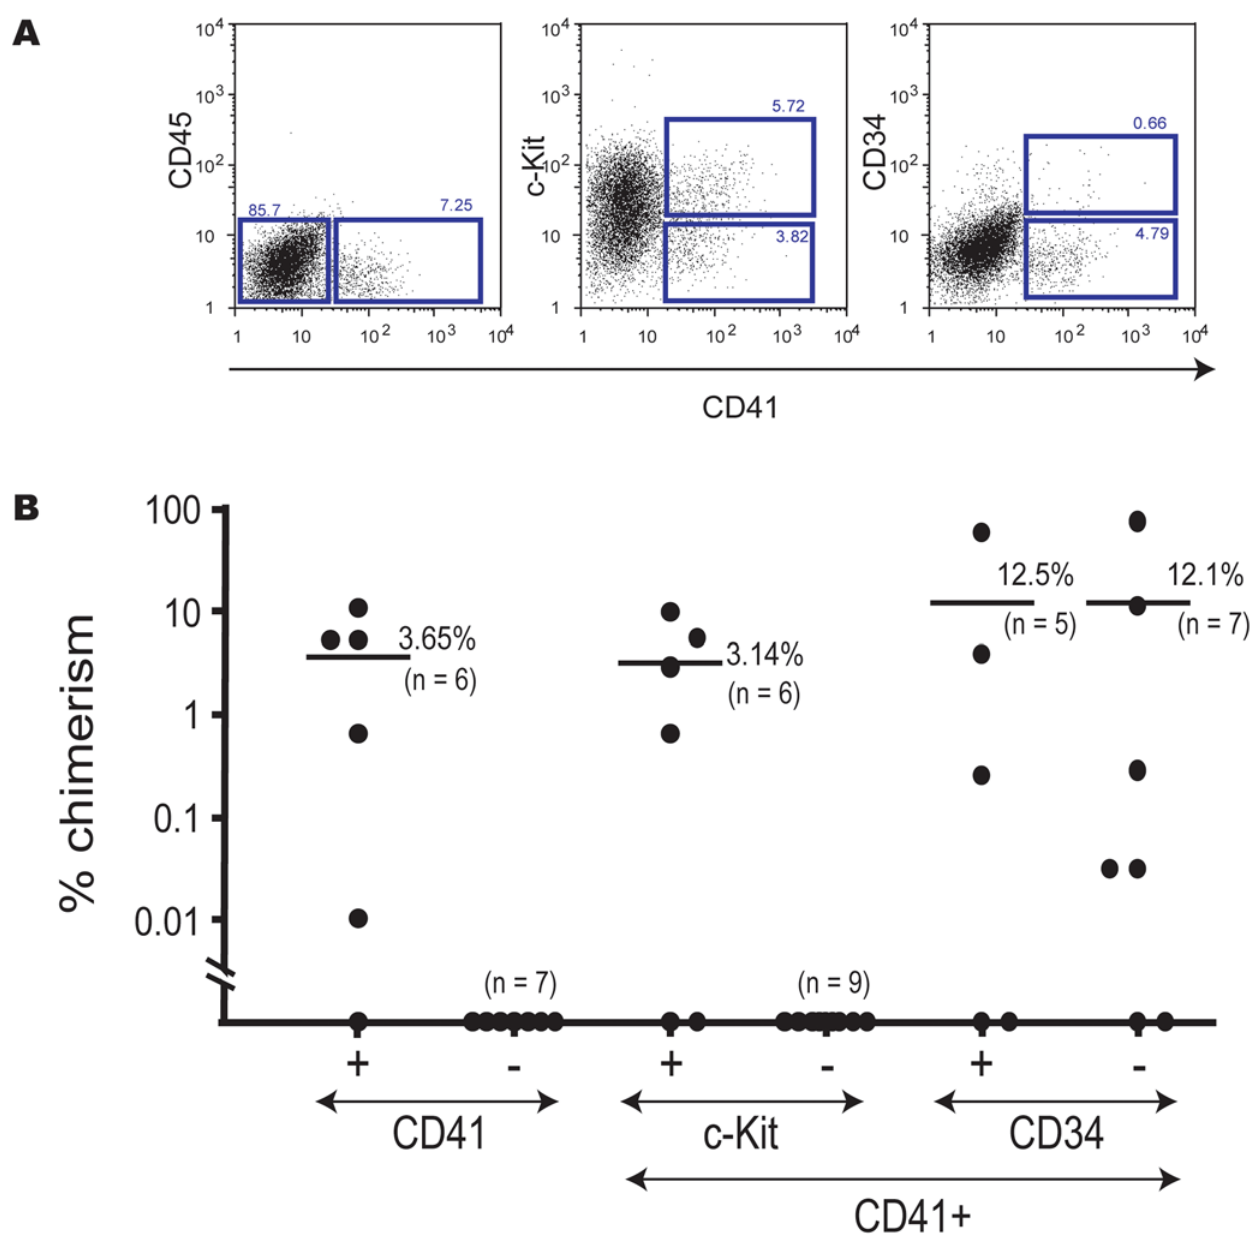
Figure 2. EB6 subpopulations with the potential of giving rise to HSCs. (A) Data from flow cytometry analysis show the expression of CD41, CD45, c-Kit, and CD34 in EB6 cells. The sorting gates for CD41 2 or CD41 + cells, c-Kit + CD41 + or c-Kit 2 CD41 + cells, and CD34 + CD41 + or CD34 2 CD41 + cells are indicated as squares. (B) EB6 cells were fractionated based on expression of CD41, c-Kit, and CD34, co-cultured with OP9 cells for 4 days, sorted for GFP + cells, and transplanted into lethally irradiated mice. HOXB4 expression was maintained from in vitro co-culture through in vivo repopulation. Recipient mice were analyzed 16 weeks after transplantation. Over 95% of reconstituted blood cells were of myeloid lineage in all cases (data not shown). Two independent experiments gave similar results. Data from one experiment are shown. See Table S1 for the number of transplanted cells from each subpopulation.